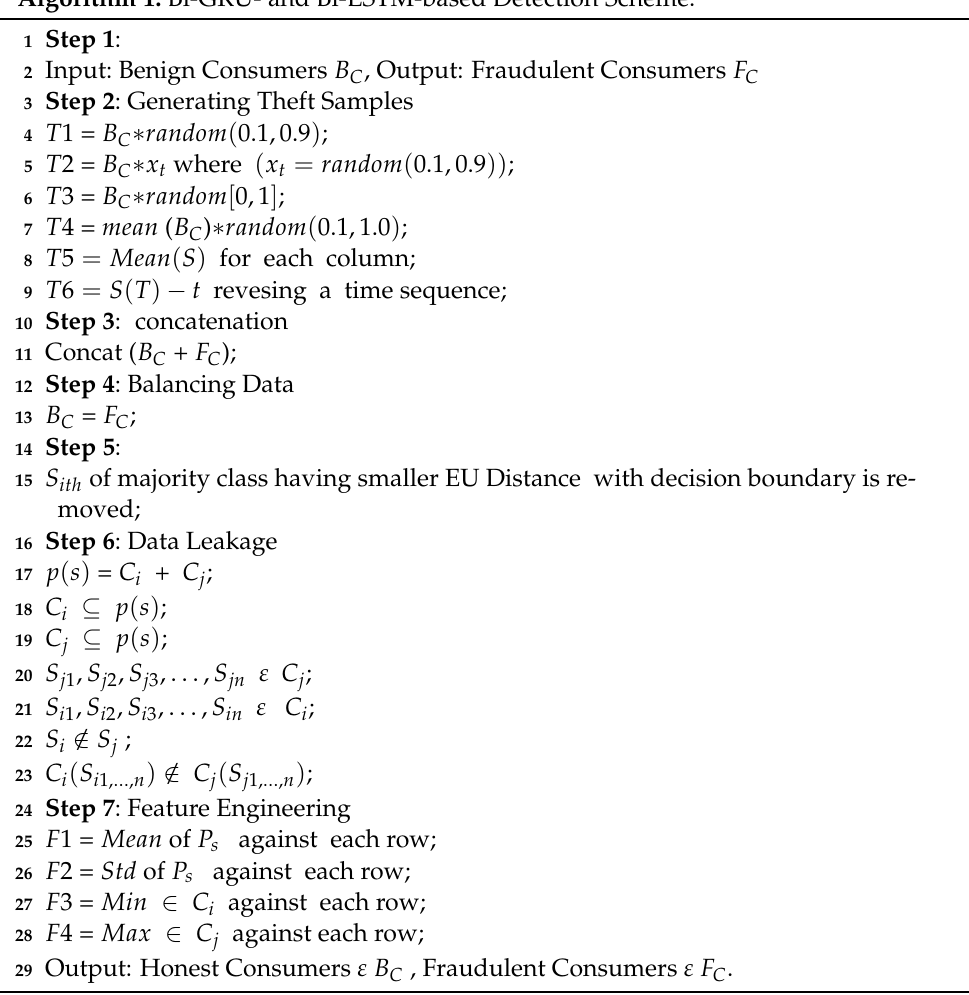
Algorithm 1: Bi-GRU- and Bi-LSTM-based Detection